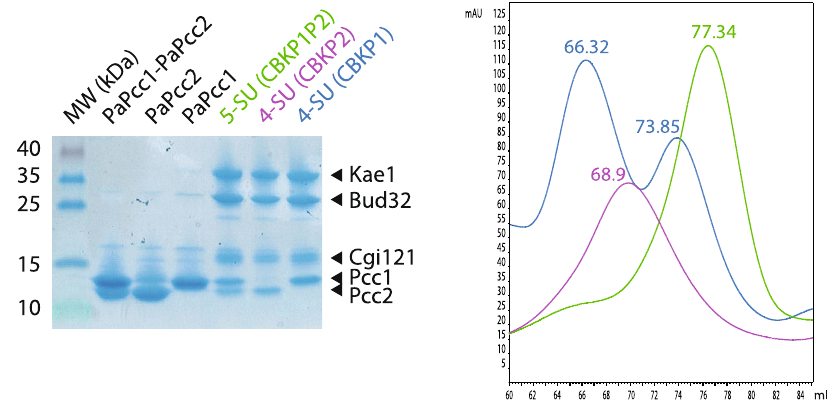
Fig.3|Puri fi cationofrecombinantPaKEOPScomplexes. SDS-PAGEanalysis(left panel) and size-exclusion chromatography pro fi les (right panel) of puri fi ed recombinant KEOPS complexes produced in E. coli cells. See Supplementary Fig.